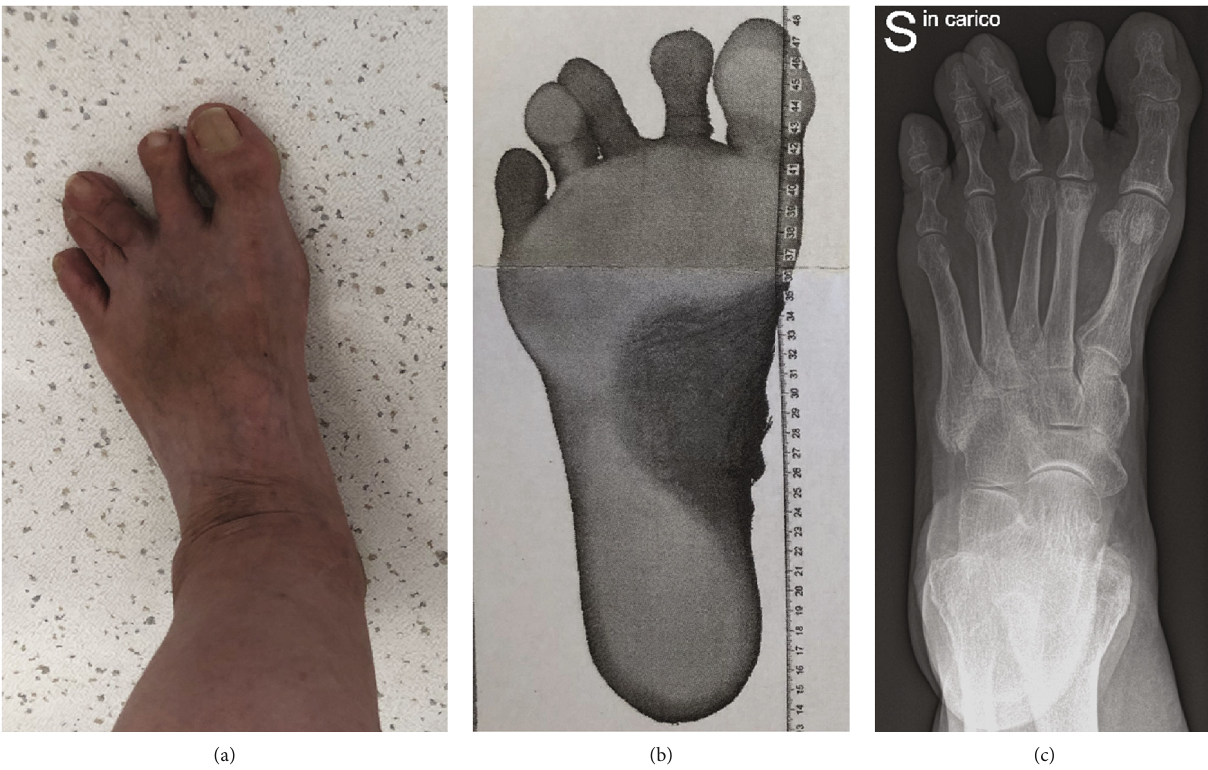
Figure 1: (a) Splay toe between 2 nd and 3 rd toe. (b) Dynamic analysis of the foot while weight bearing. (c) Plane X-ray of the foot showing